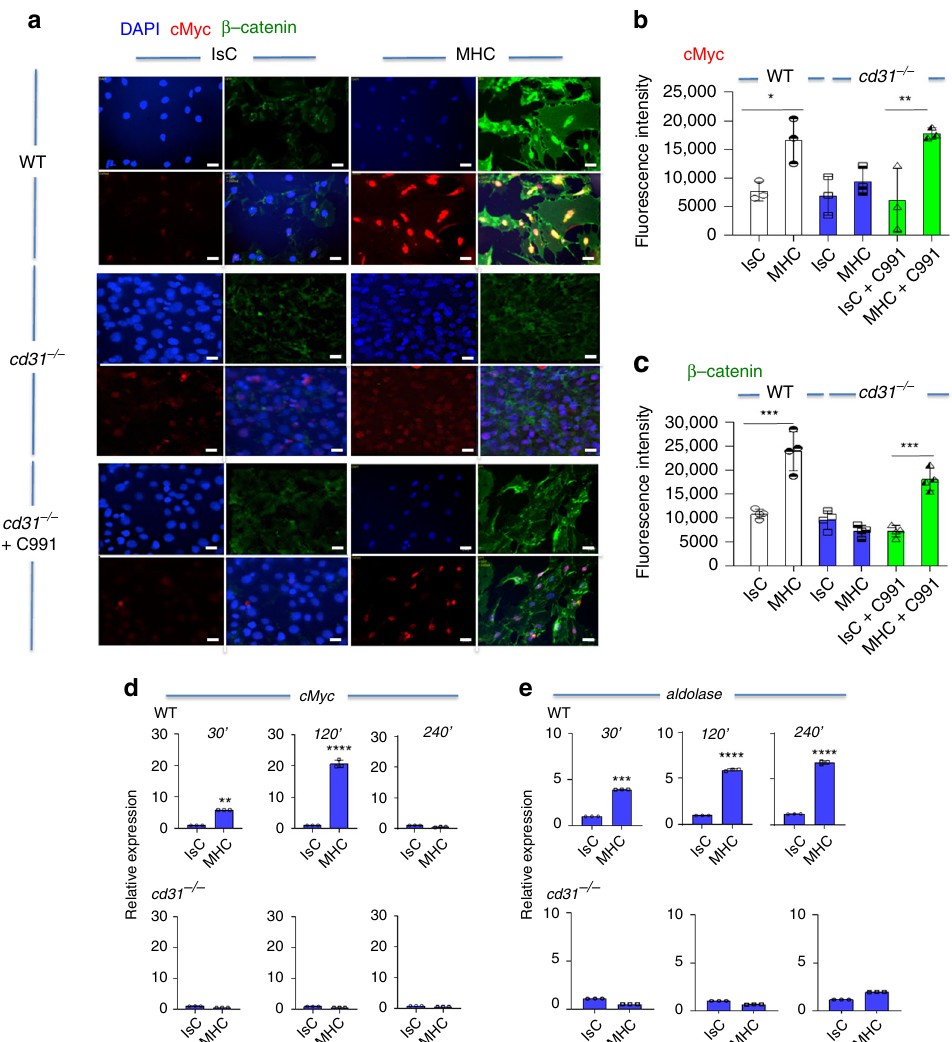
Fig. 7 CD31 signaling promotes β -catenin nuclear translocation and upregulates cMyc expression. WT and cd31 − / − EC monolayers were stimulated by MHC antibody-ligation or treated with an Isotype-matched control and secondary antibodies (2 h). Some cd31 − / − ECs were also treated with an Akt activator (500 nM, 3 h) prior to antibody stimulation. Vehicle was added in the untreated cultures (IsC and MHC ligation). a β -catenin and cMyc expression were determined by immuno fl uorescent antibody staining and wide- fi eld microscopy. The nucleus was stained with DAPI. The mean fl uorescence intensity of cMyc and β -catenin measured in 500 cells in three independent experiments is shown in ( b , c ), respectively. Scale bar = 40 μ m. Data are mean ± SD. one-way Anova with Tuckey post-hoc test. b WT IsC vs WT MHC; c WT IsC vs WT MHC *** p = 0.0008, cd31 − / − IsC + C991 vs cd31 − / − MHC + C991 *** p = 0.0002. d , e : cMyc ( d ) and aldolase ( e ) gene transcription by WT (upper panels) and cd31 − / − (lower panels) EC at the indicated time points. n = 3 biologically independent samples, N = 2 independent experiments. Error bars represent SD. One-way Anova with